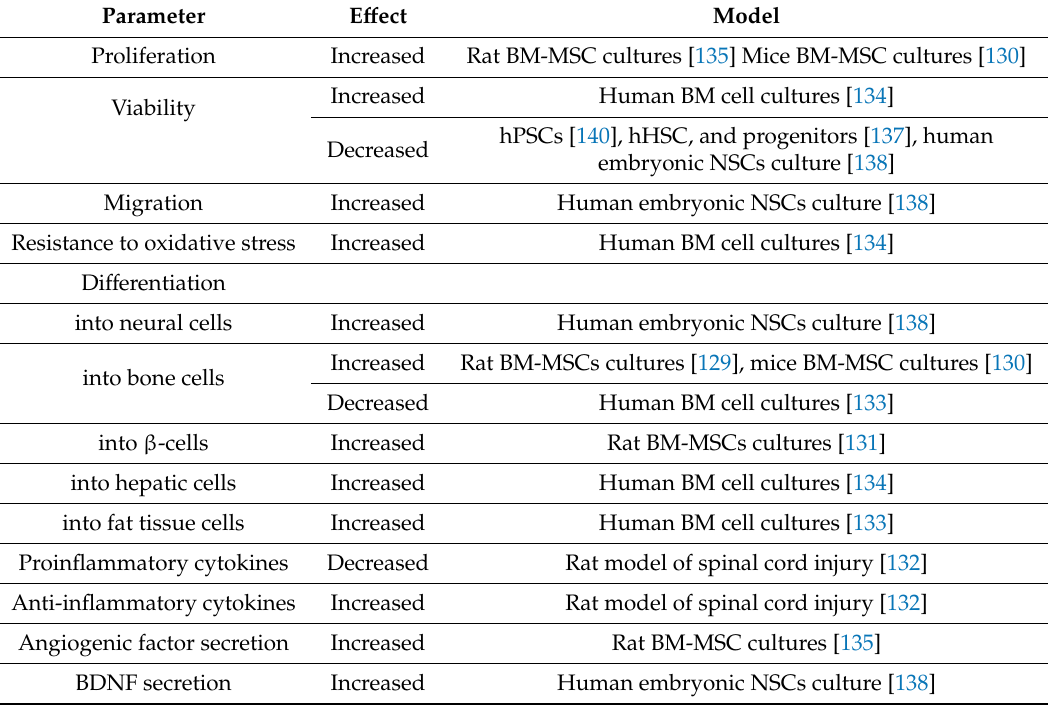
Table 4. Positive and negative e ff ects of quercetin on mesenchymal stem